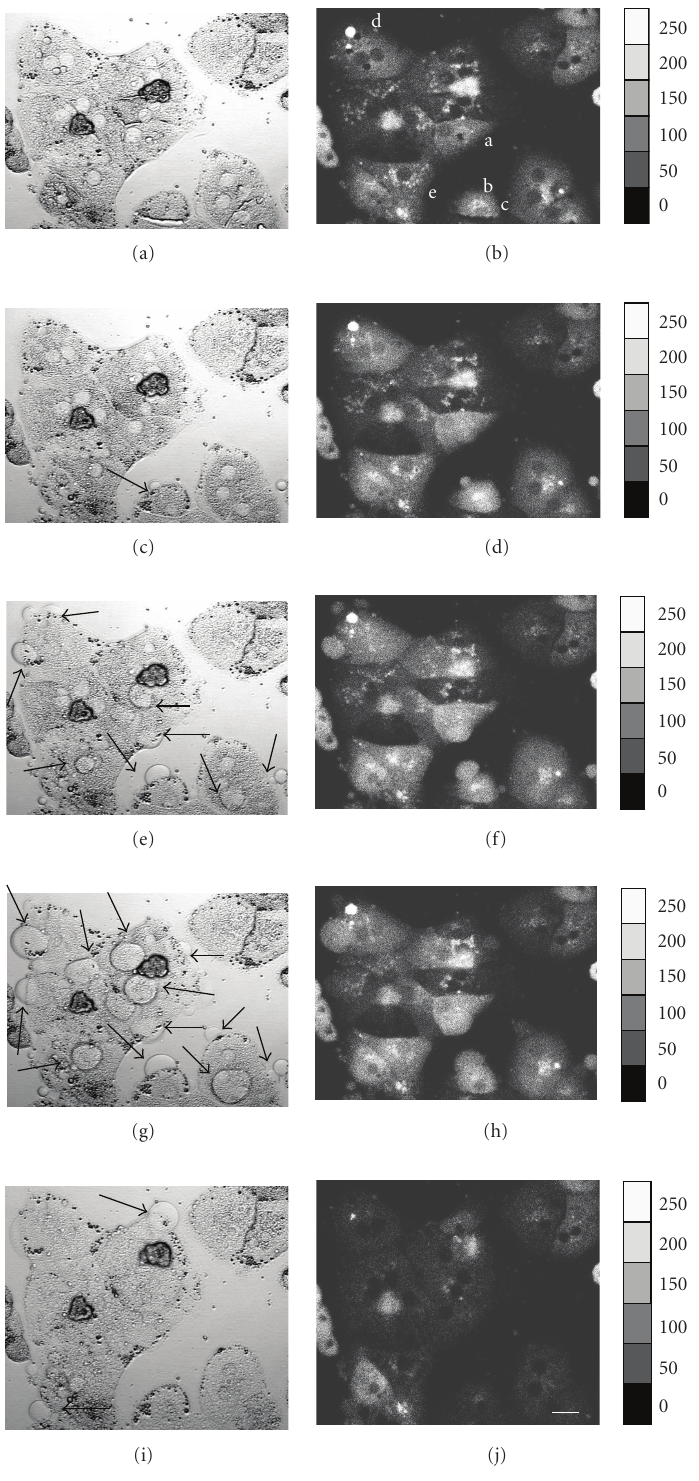
Figure 1: Changes in the fluorescence intensity of intracellular calcium in TBH-treated hepatocytes. Using confocal microscopy, the changes of cell morphology were also photographed before (a), 12 (c), 18 (e), 30 (g), and 60min (i) after 2.0mM TBH treatment. At the same time, the changes of fluorescence intensity of intracellular calcium were photographed before (b), 12 (d), 18 (f), 30 (h) and 60min (j) after 2.0 mM TBH treatment. Pseudodensity scale indicates fluorescence intensity in arbitrary units. Arrows indicate the cells with bleb. Bar, 20 μ